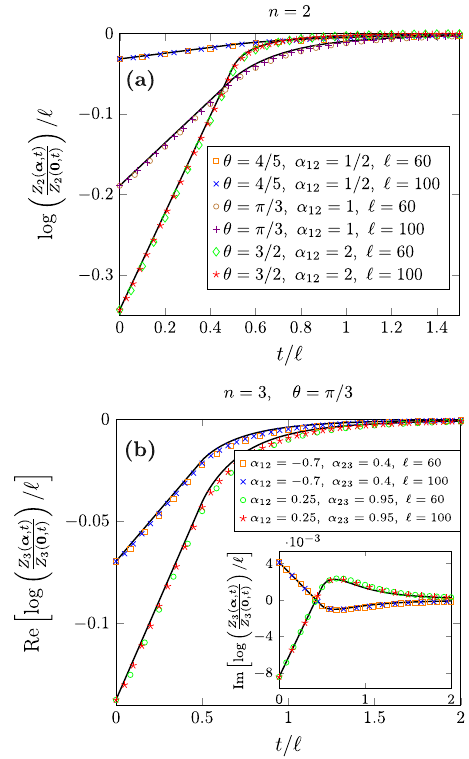
Fig. 5 | Time evolution of the charged moments Z n ( α , t ) after the quench (11). We plot them as a function of t / ℓ for the replica indices n =2 (panel a ) and n =3 (panel b ) and several values of the initial tilting angle θ , the subsystem size ℓ , and the phases α j , j +1 . The symbols were obtained numerically using Eq. (19) and the continuous lines correspond to the analytic prediction (20). Source data are pro- vided as a Source Data fi